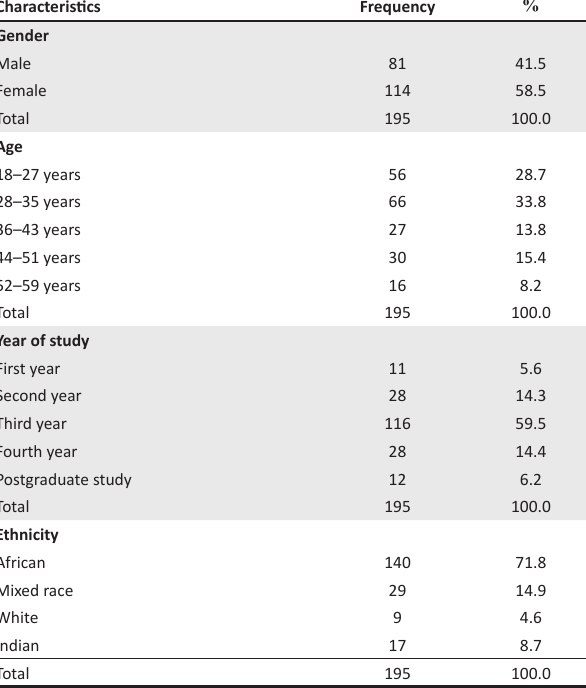
TABLE 1: Demographic profile of the respondents. Characteristics